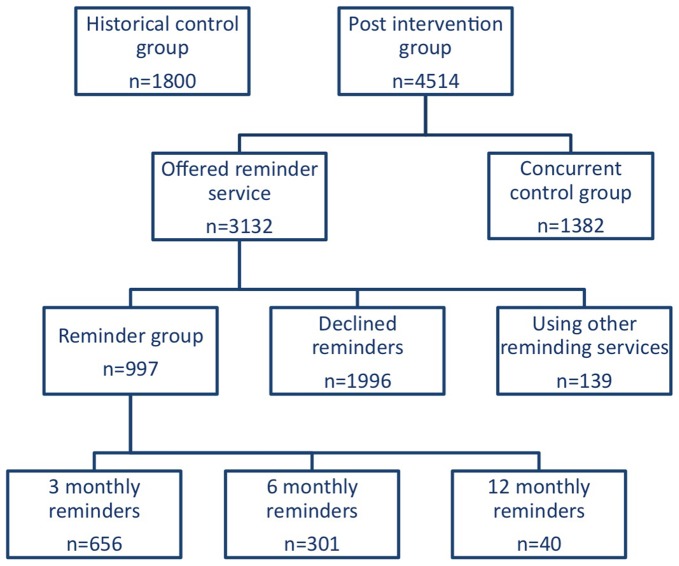
Flow chart of study groups.